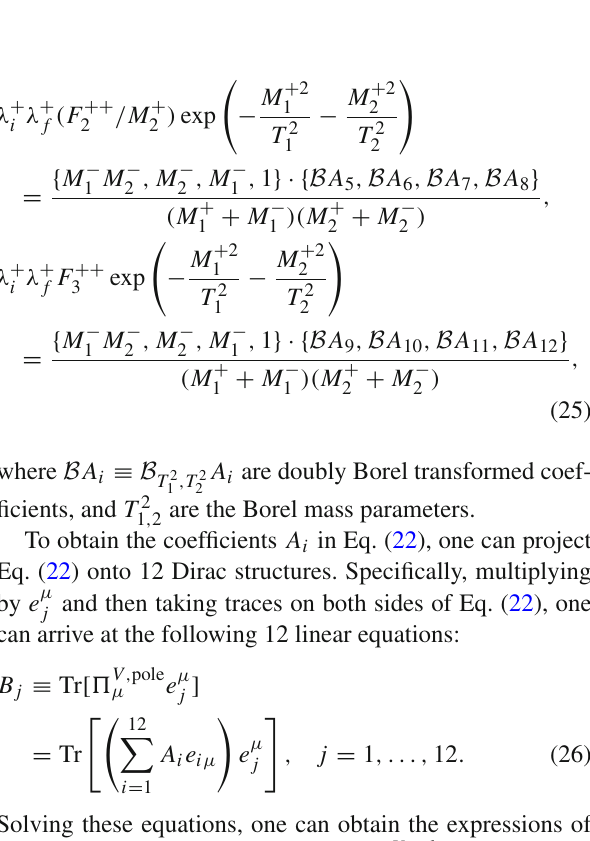
Fig. 3 Only three nonzero diagrams survive for the three-point corre- lation function of (cid:2) b decaying into (cid:2) c , if we consider the contributions up to dimension-5 and neglect those from dimension-4. The double